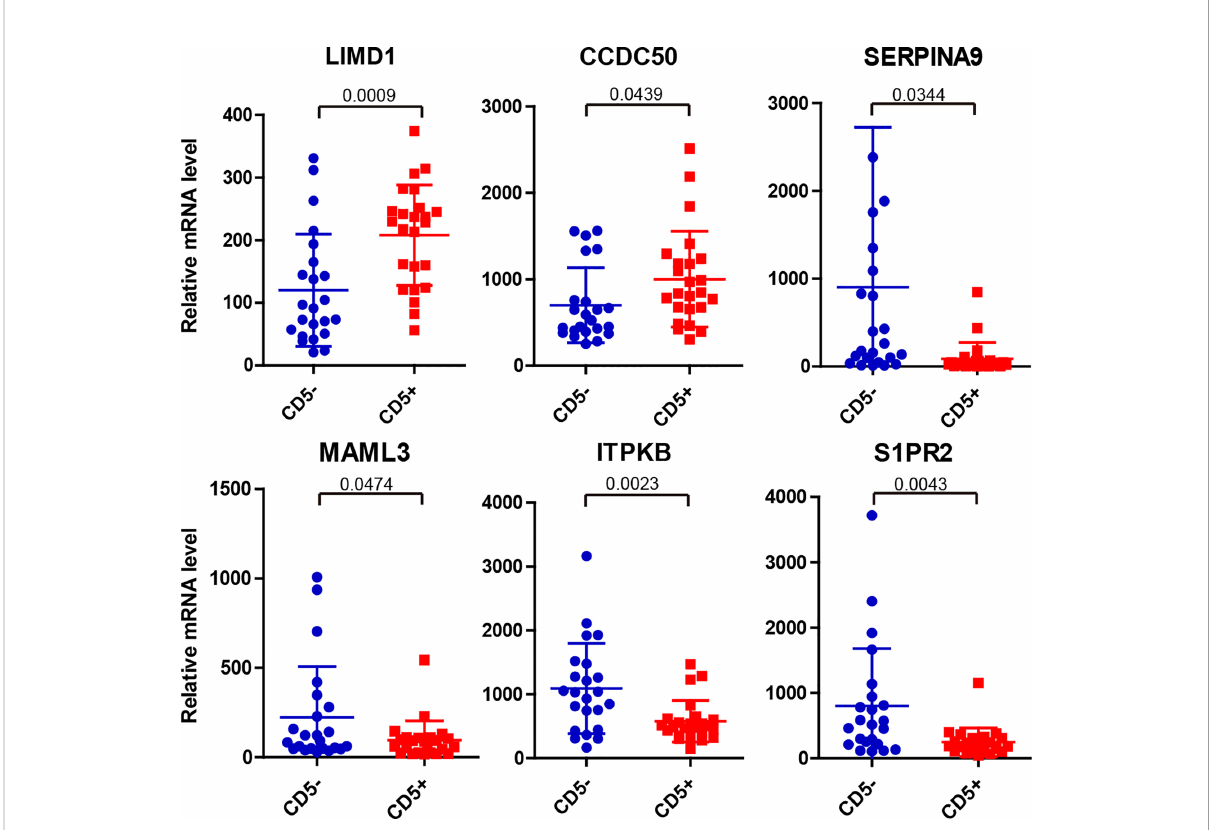
FIGURE 5 Signi fi cantly differentially expressed mRNA between CD5- and CD5+ DLBCL as detected by Lymph2Cx assay on the NanoString platform. Compared with CD5- DLBCL, LIMD1 and CCDC50 were upregulated whereas SERPINA9 , MAML3 , ITPKB , and S1PR2 were downregulated in CD5+